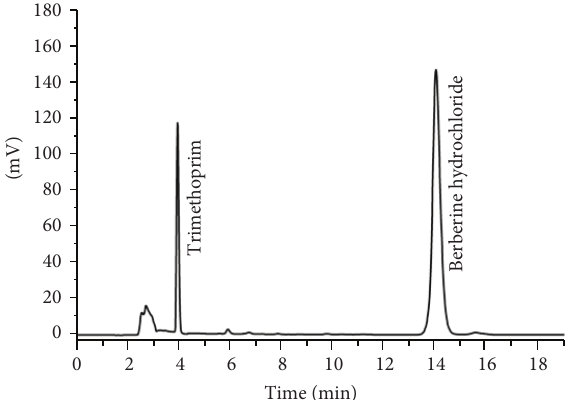
F 5: Typical HPLC chromatogram of combined capsule sample